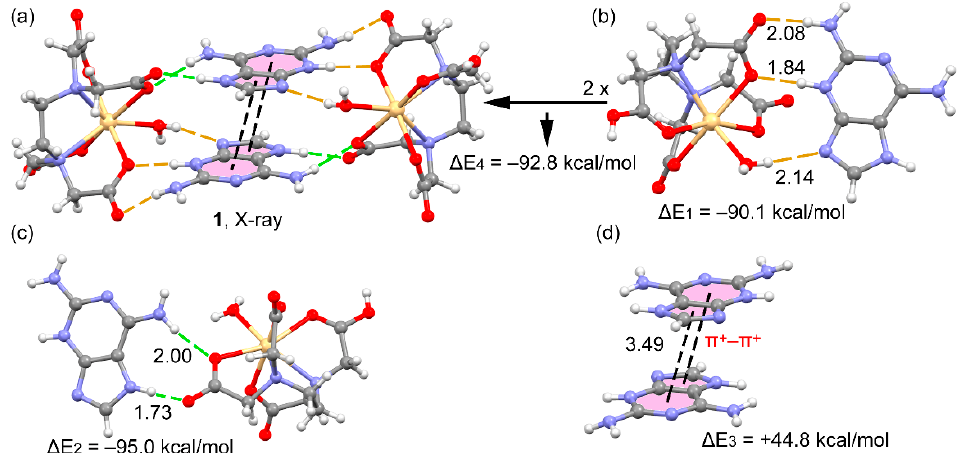
Figure 7. ( a ) Partial view of the X-ray solid state of 1 showing the self-assembled tetramer. ( b,c ) H-bonded dimers extracted from the assembly dimers. ( d ) Isolated π , π -stacked dimer of H2dap + moieties. The distances are given in Å.